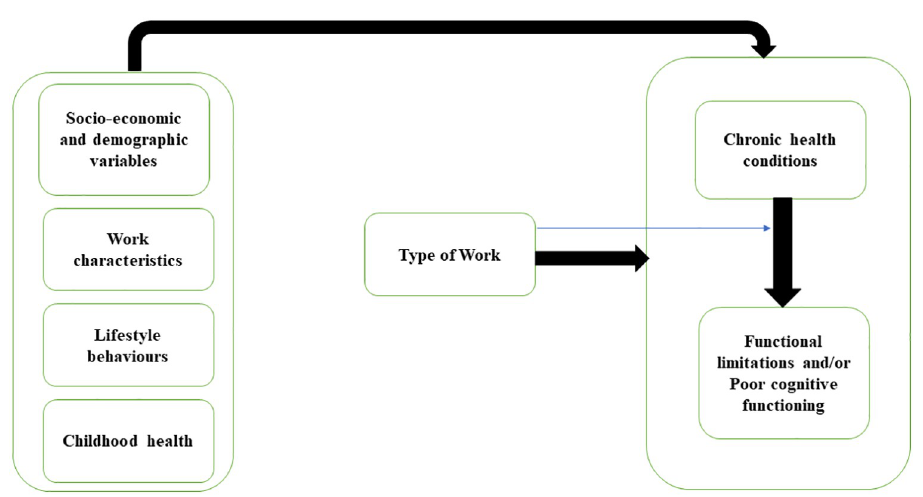
Fig 1. Research framework. Note: Blue line represent moderation